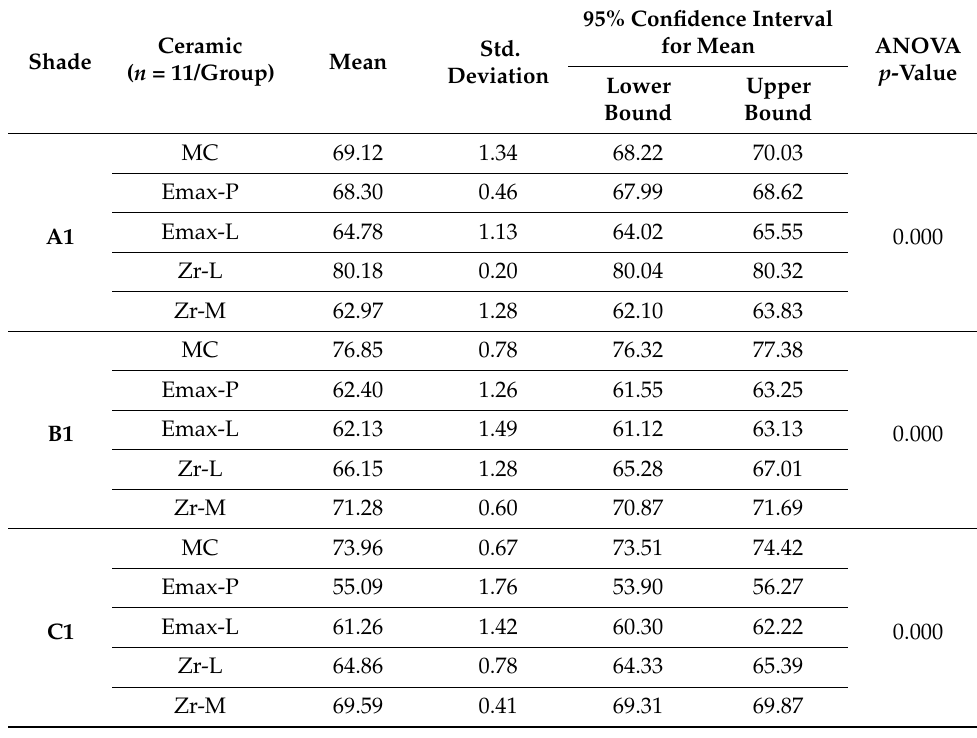
Table 3. Mean and standard deviation of the delta E ( ∆ E) of the tested ceramic materials ( N = 165). 95% Confidence Interval Ceramic for Mean ANOVA Std. Mean Shade p -Value ( n = 11/Group) Deviation Lower Upper Bound